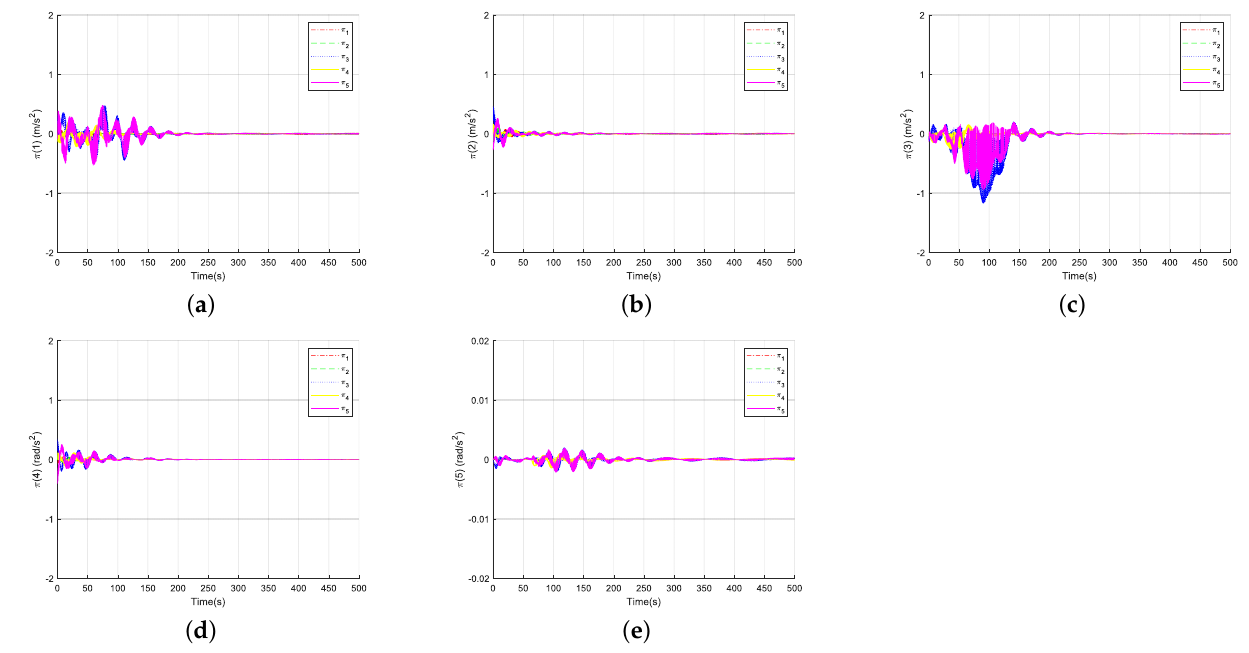
Figure 7. The π state of the multi − AUV formation: ( a ) the π ( 1 ) state of multi − AUV, ( b ) the π ( 2 ) state of multi − AUV, ( c ) the π ( 3 ) state of multi − AUV, ( d ) the π ( 4 ) state of multi − AUV, ( e ) the π ( 5 ) state of multi − AUV.